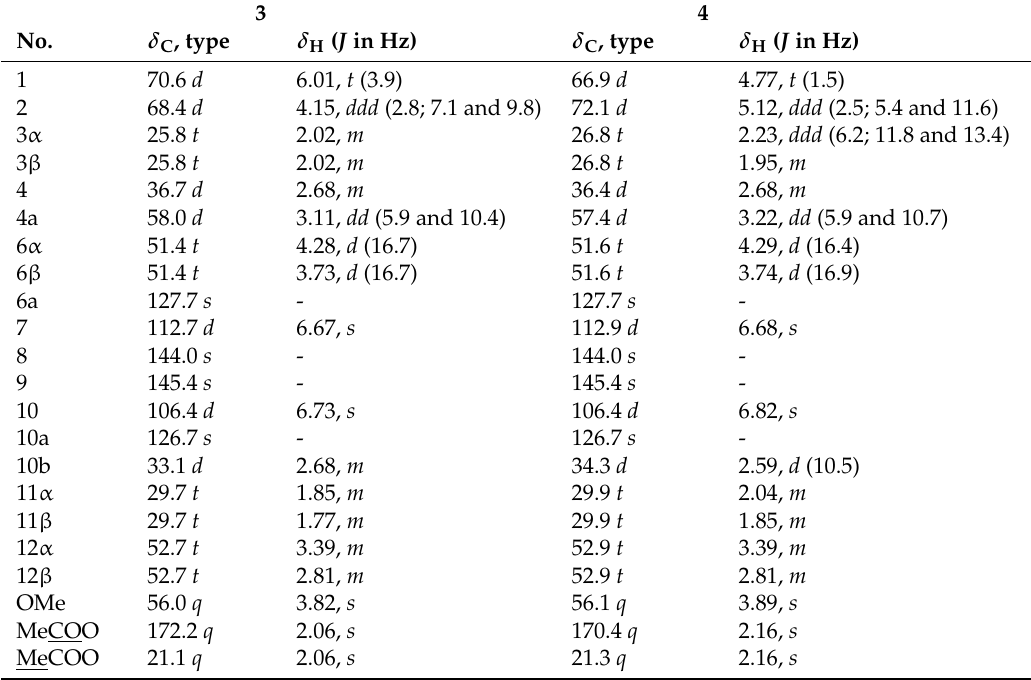
Table 4. In vitro antiprotozoal and cytotoxic activities of 1 and 2 . Values expressed in µg ml -1 .